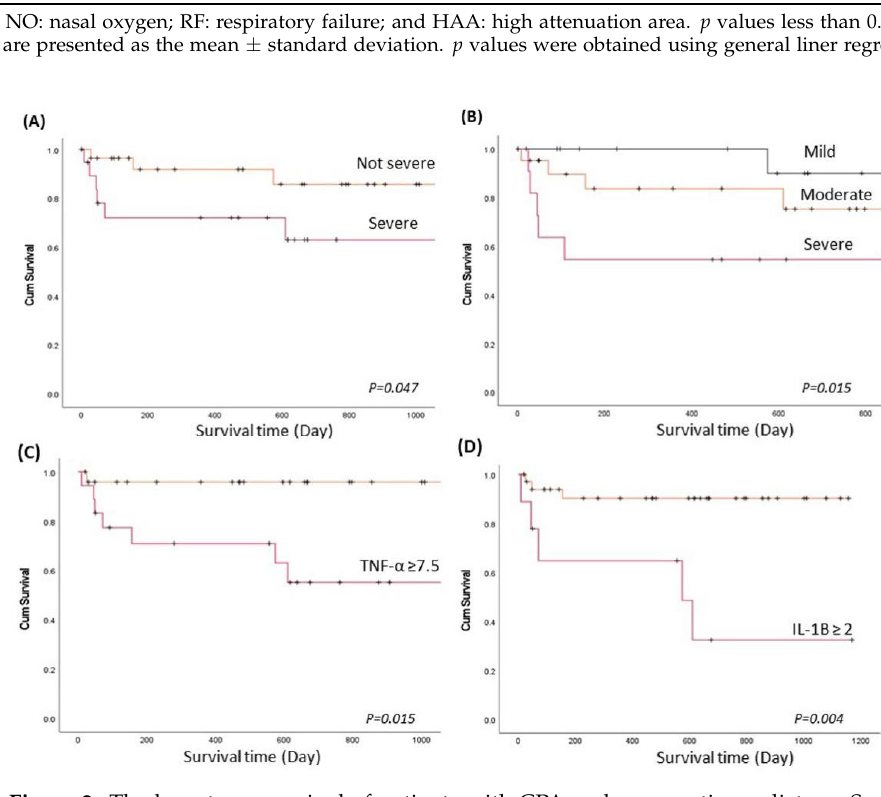
Figure 2. The long-term survival of patients with CPA and prognostic predictors. Survival analysis using the Kaplan–Meier (KM) method to evaluate the CPA severity score and inflammatory biomarkers to predict long-term survival. p values were determined using the Breslow (generalized Wilcoxon) test. ( A ). KM plot by severity of CPA using lung parenchyma analysis profiles when the HAA ≥ 13%, skewness < 1.8, or kurtosis < 2.5 (severe), compared to the HAA < 13%, skewness ≥ 1.8, and kurtosis ≥ 2.5 (not severe). ( B ). KM plot by CPA severity using the visual categorization method. ( C ) KM plot by TNF-α level (pg/mL) in peripheral blood at study entry. ( D ) KM plot by IL-1B level (pg/mL) in peripheral blood at study entry.